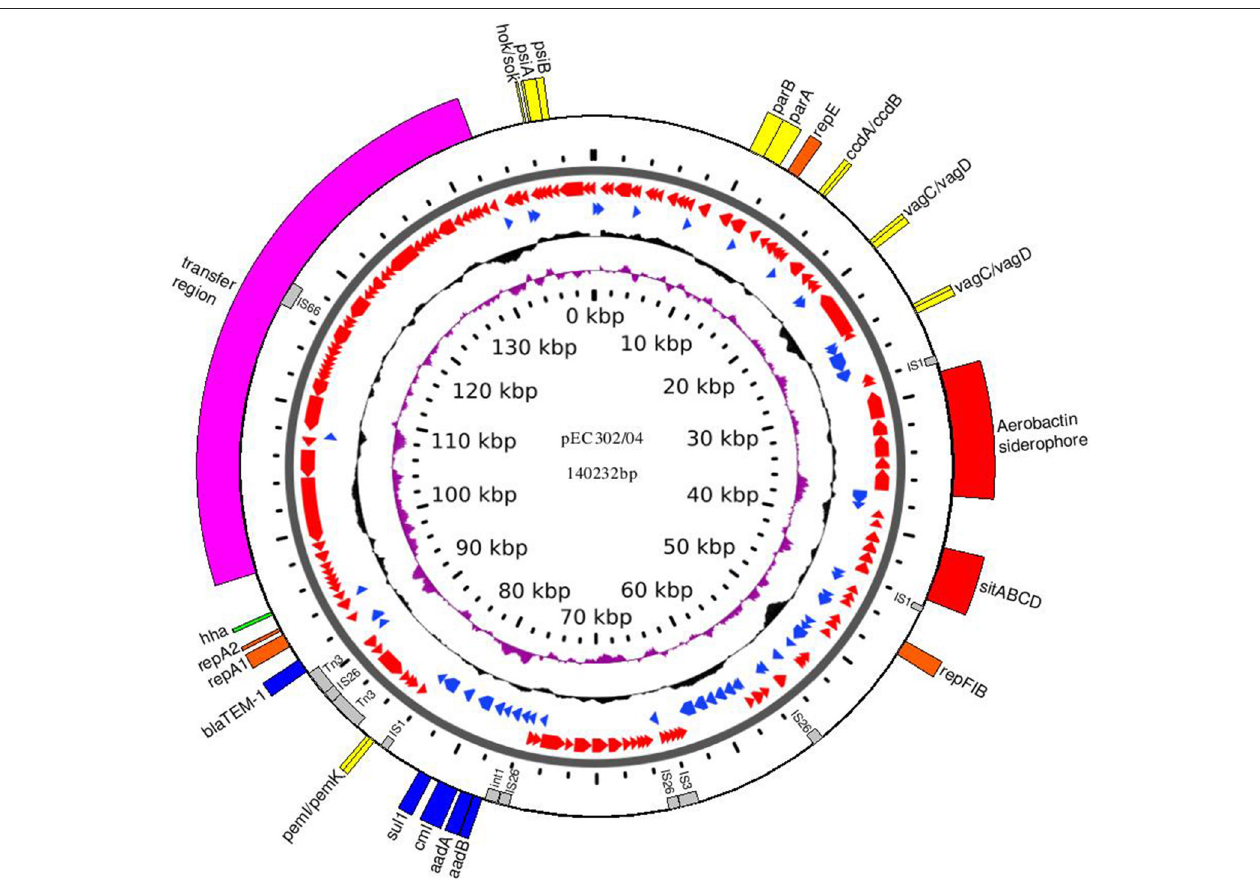
FIGURE 1 | Circular map of plasmid pEC302/04. The 1st (innermost ring) and the 6th rings show the plasmid size in kbp. The 2nd and 3rd rings (from inner to outer) show the GC skew (purple) and GC content (black), respectively. The 4th and 5th rings show the ORFs in forward (blue) and reverse orientation (red). The outermost ring shows the important genes encoding regions highlighting with different colors according to its function: orange, replication; pink, transfer region; yellow, addictive systems; red, iron acquisition systems; blue, antimicrobial resistance; green, other virulence factor; gray, IS elements.